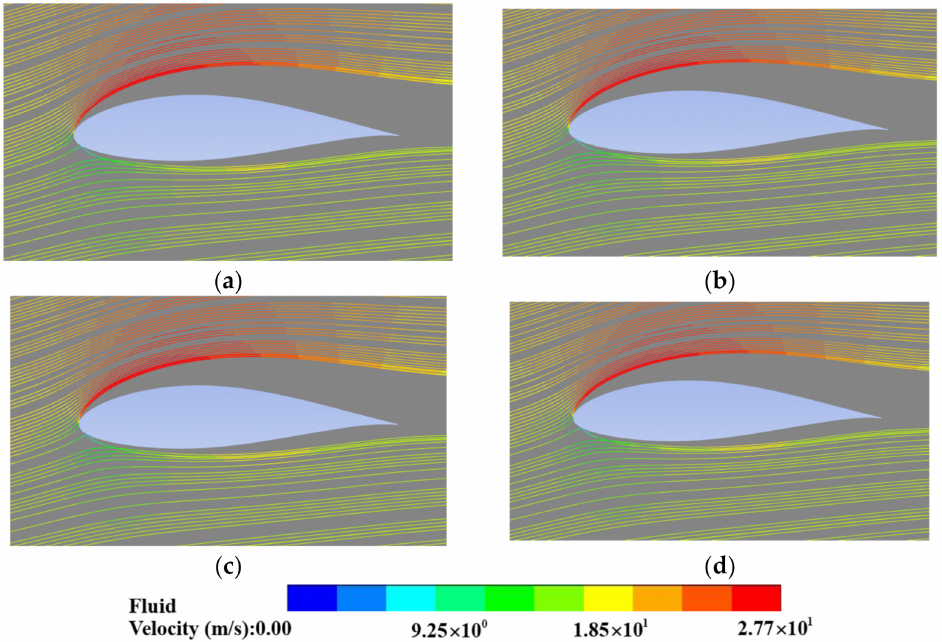
Figure 17. The particle trajectories under different particle concentrations: ( a ) 0.5 g/L; ( b ) 1 g/L; ( c ) 1.5 g/L; ( d ) 2 g/L.